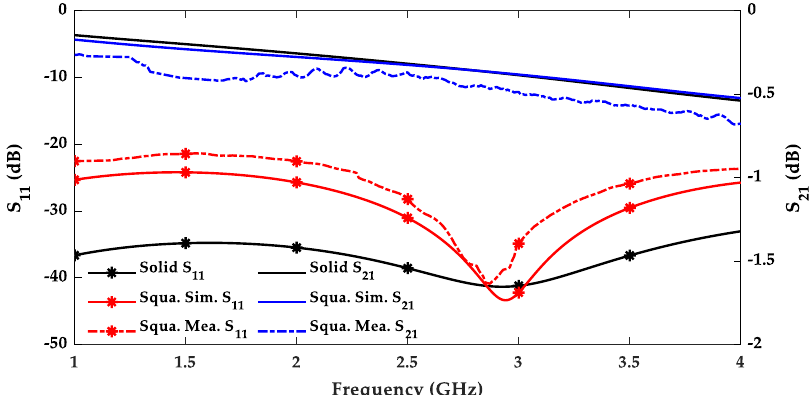
Figure 5. Simulated and measured s-parameter of solid feedline and square-meshed feedline.